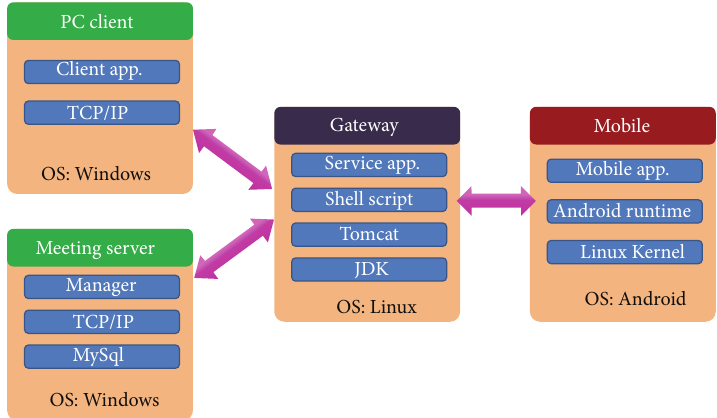
Figure 5: Smart work system construction